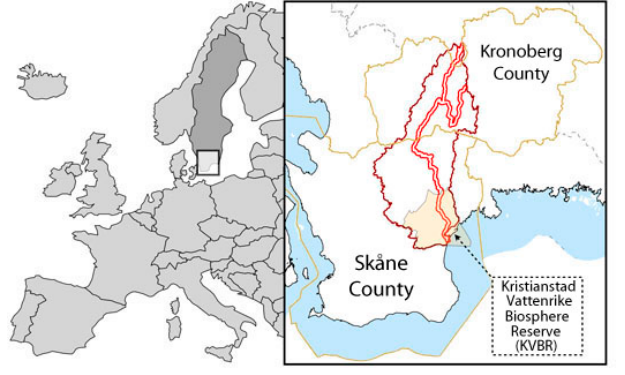
Fig. 1. Map of River Helge å catchment in